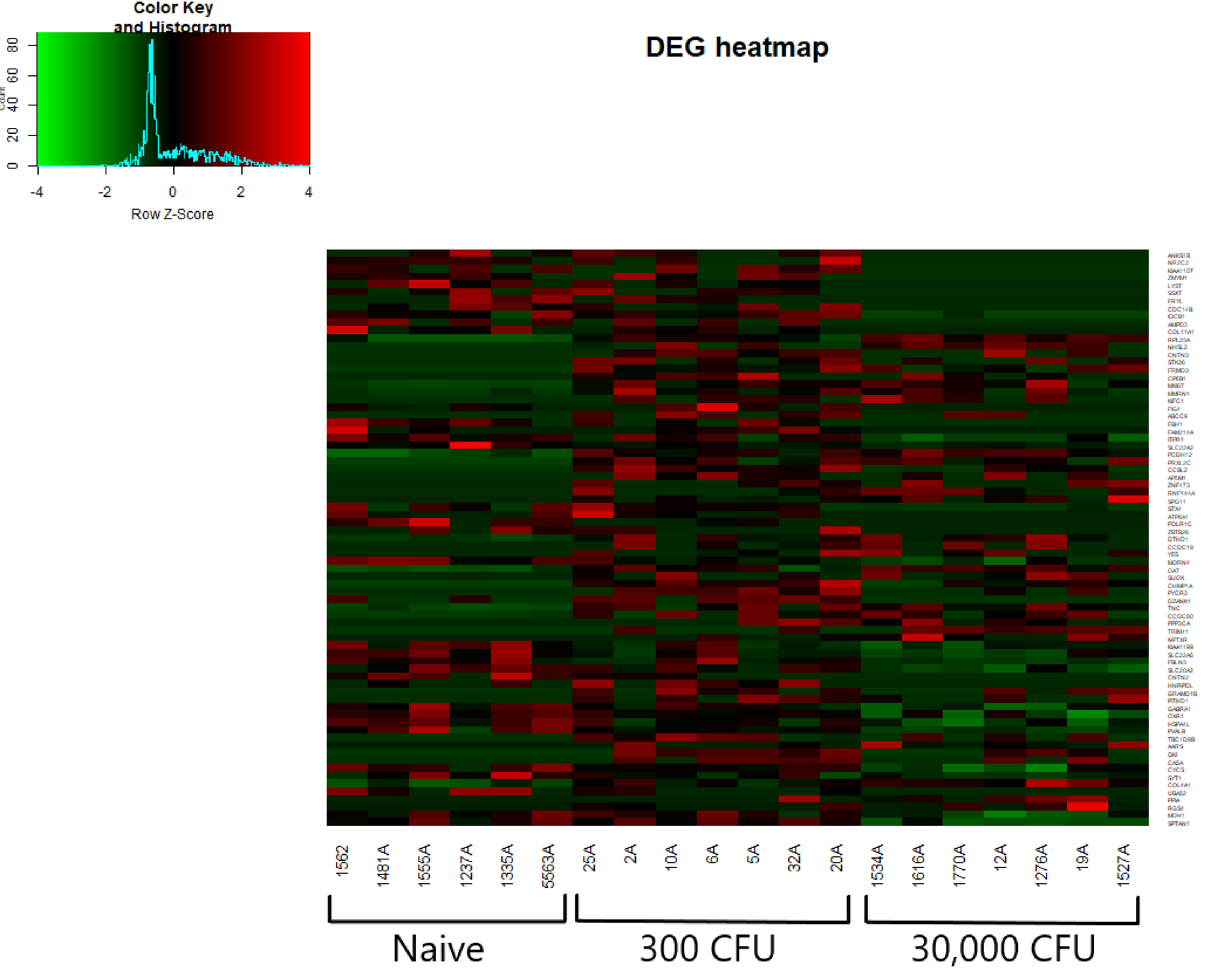
Higher values indicated in red represents higher expression. Key indicates frequency of FPKM values based on Z-score or number of standard deviations above or below the